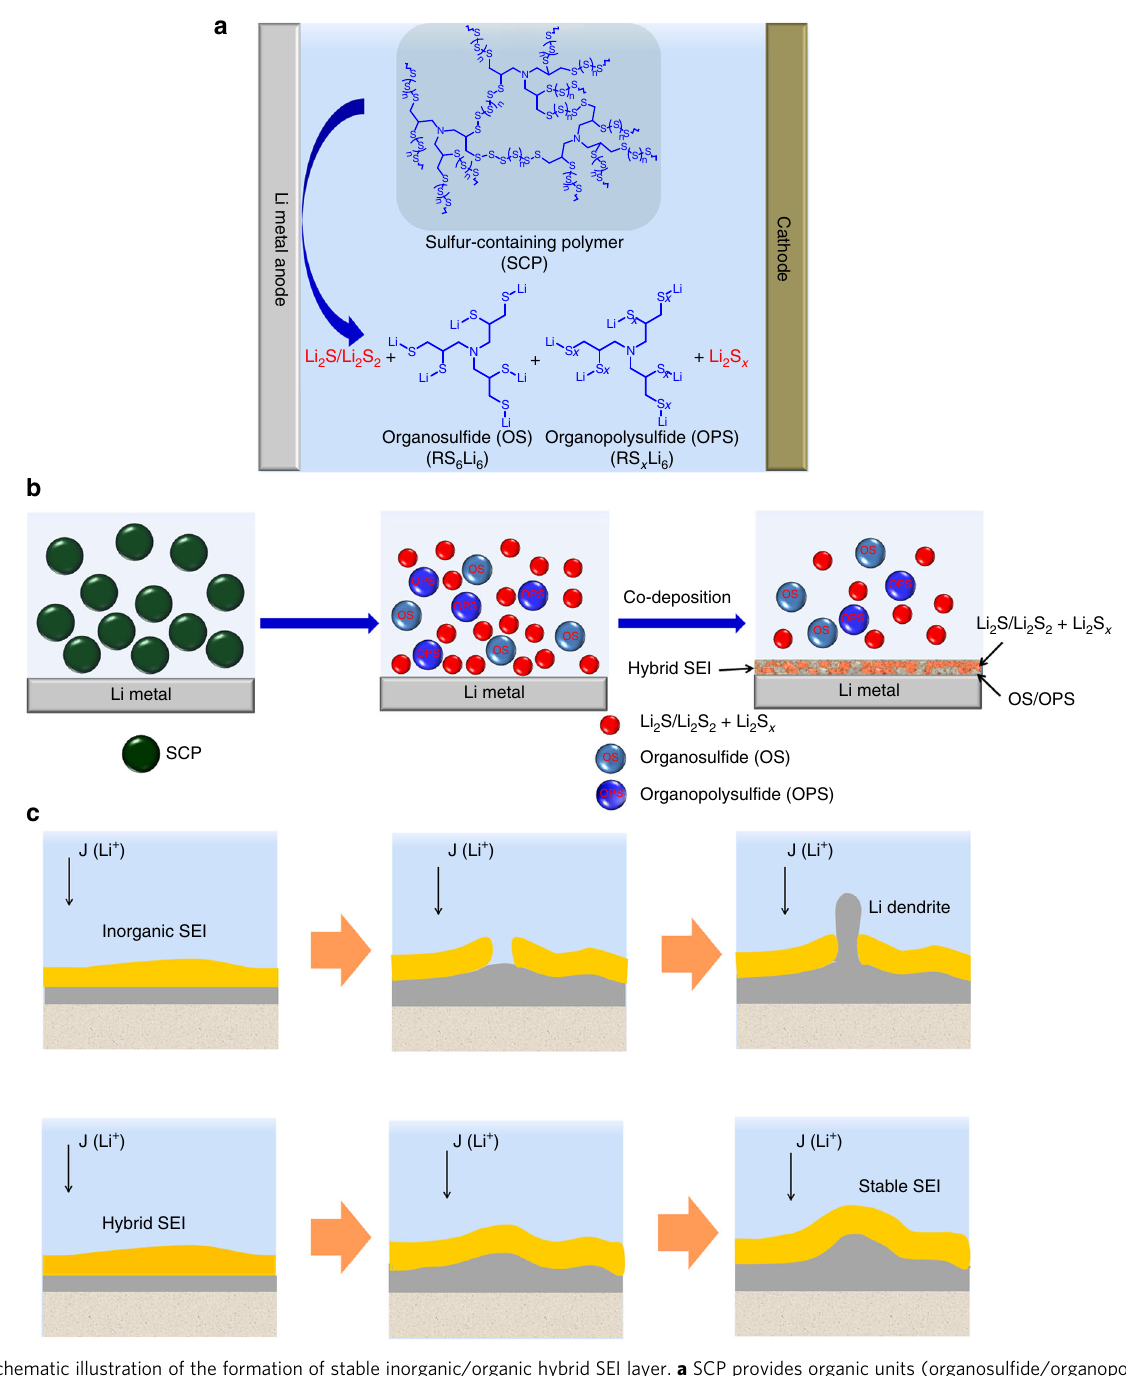
Fig. 1 Schematic illustration of the formation of stable inorganic/organic hybrid SEI layer. a SCP provides organic units (organosul fi de/organopolysul fi de) and inorganic units (Li 2 S/Li 2 S 2 ) in the electrolyte. b Schematics of the formation of organosul fi des/organopolysul fi des - Li 2 S/Li 2 S 2 hybrid SEI layer. c The protection of the Li metal by the stable inorganic/organic hybrid SEI